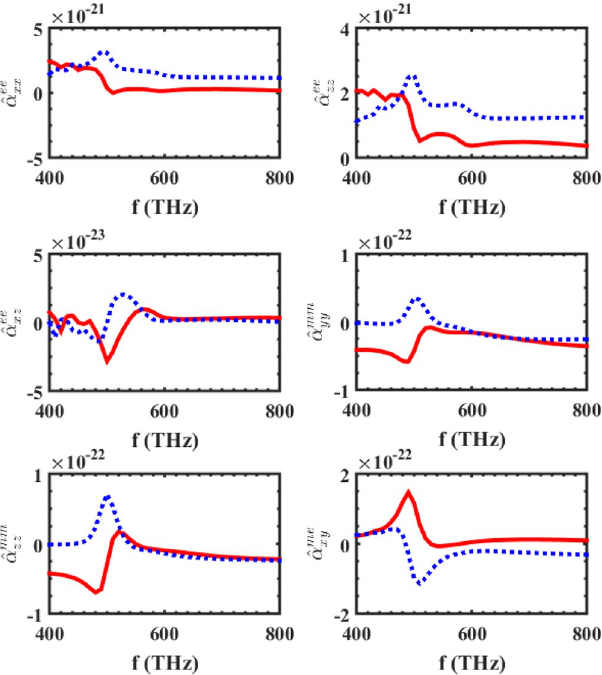
Figure 7. The main component of the polarizabilities of the supercell shown in Fig. 6 placed on an infinite SiO 2 substrate, with ε r = 2.25 . The center-to-center distance of the elements is considered to be 150